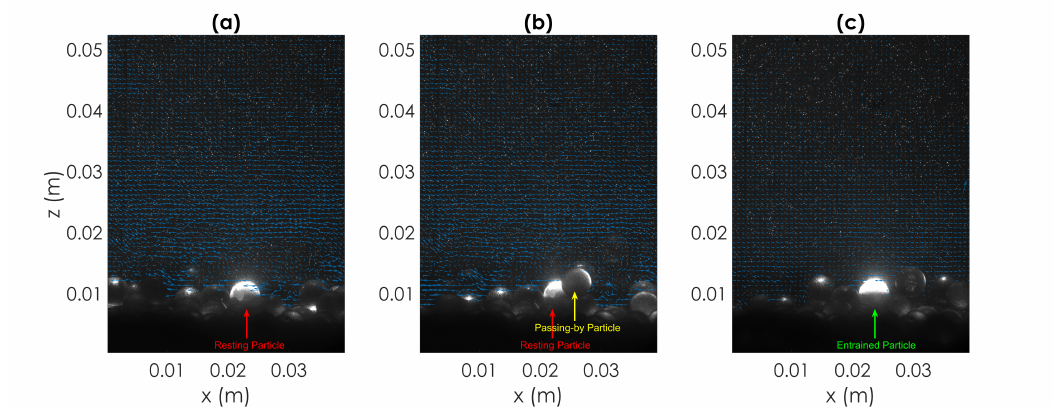
Figure 13. Particle entrained because of particle passing-by (Type B; Particle 3, Test T2). Sequence of three PIV images respectively showing (from ( a – c )): at time t = t 0 (2 time instants, corresponding to 0.1333 s, before entrainment) the bright particle located in the centre of the image is at rest in the bed; at time t = t 0 + ∆ t (1 time instant, corresponding to 0.067 s, before entrainment) the particle is still at rest in the bed and a particle perturbating the flow field passes nearby; at time t = t 0 + 2 ∆ t the particle starts its entrainment. (For clarity only 1 out of 2 vectors are